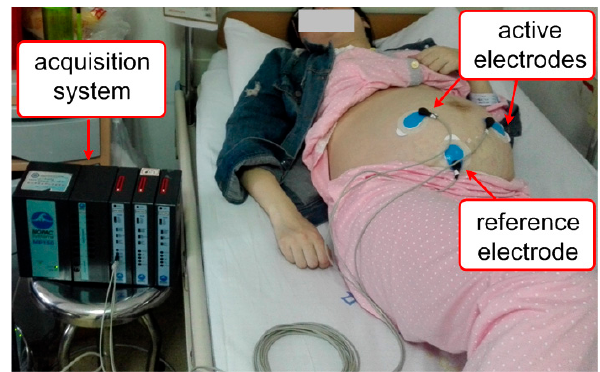
Figure 4. Experimental settings for capturing DB2.